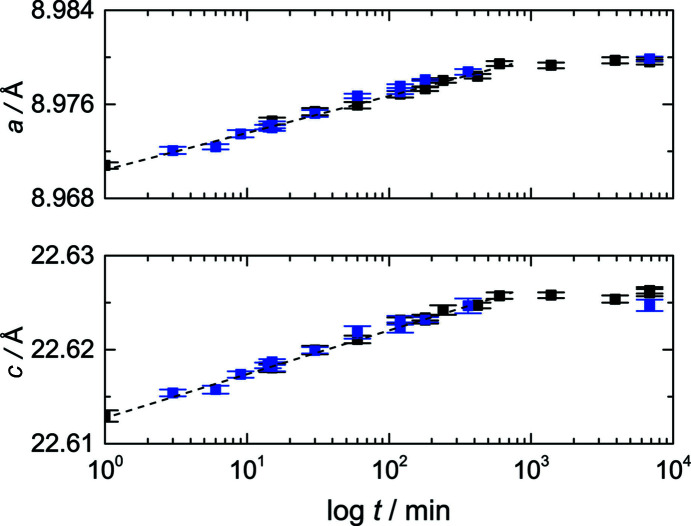
The change of lattice parameters a and c with immersion time of Na3Sc2(PO4)3 polycrystalline material in 1 molar AgNO3 solution.